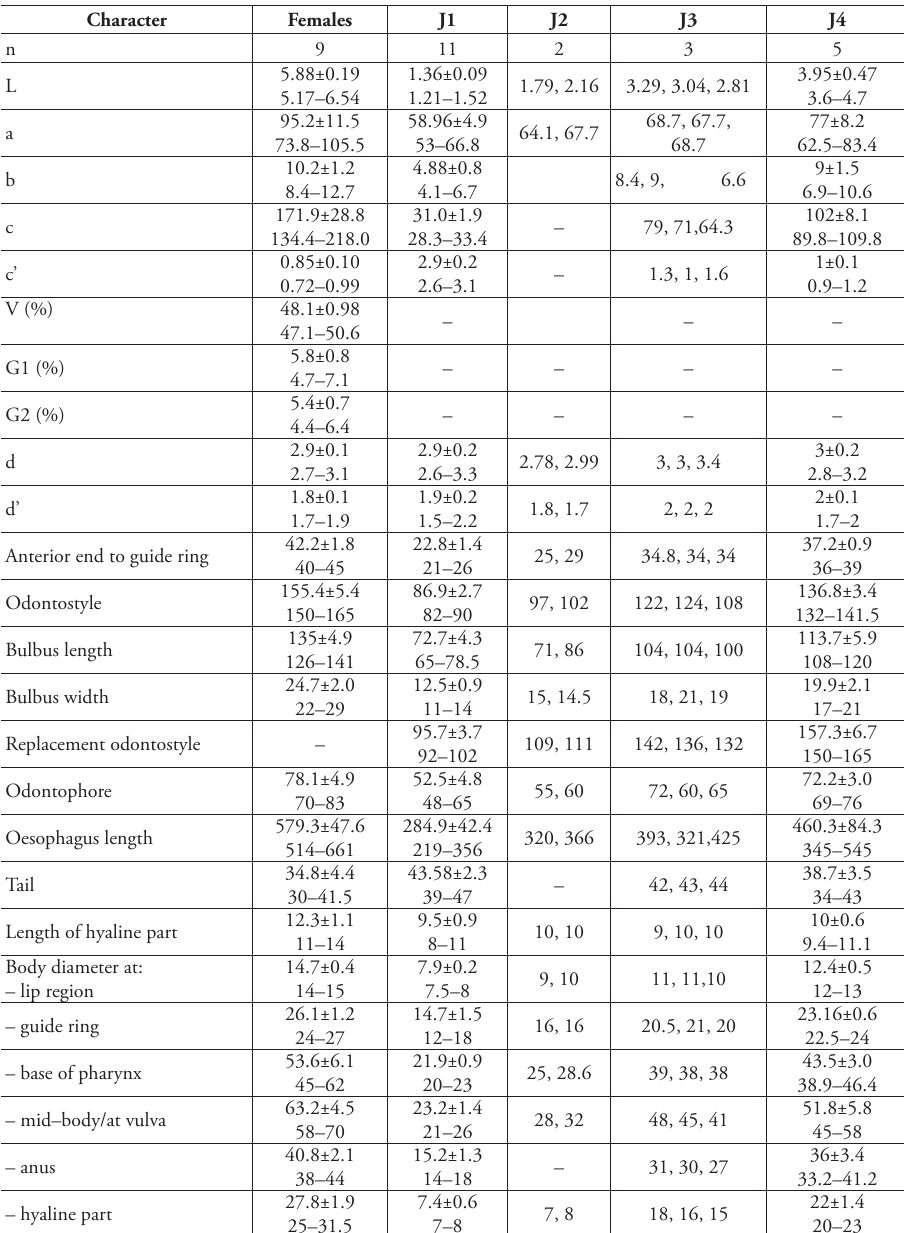
Table 2. Measurements of females and juvenile stages (J) of Longidorus piceicola from Cernica-Ilfov County, Romania (mean ± standard deviation, with range). All measurements in micrometers except body length